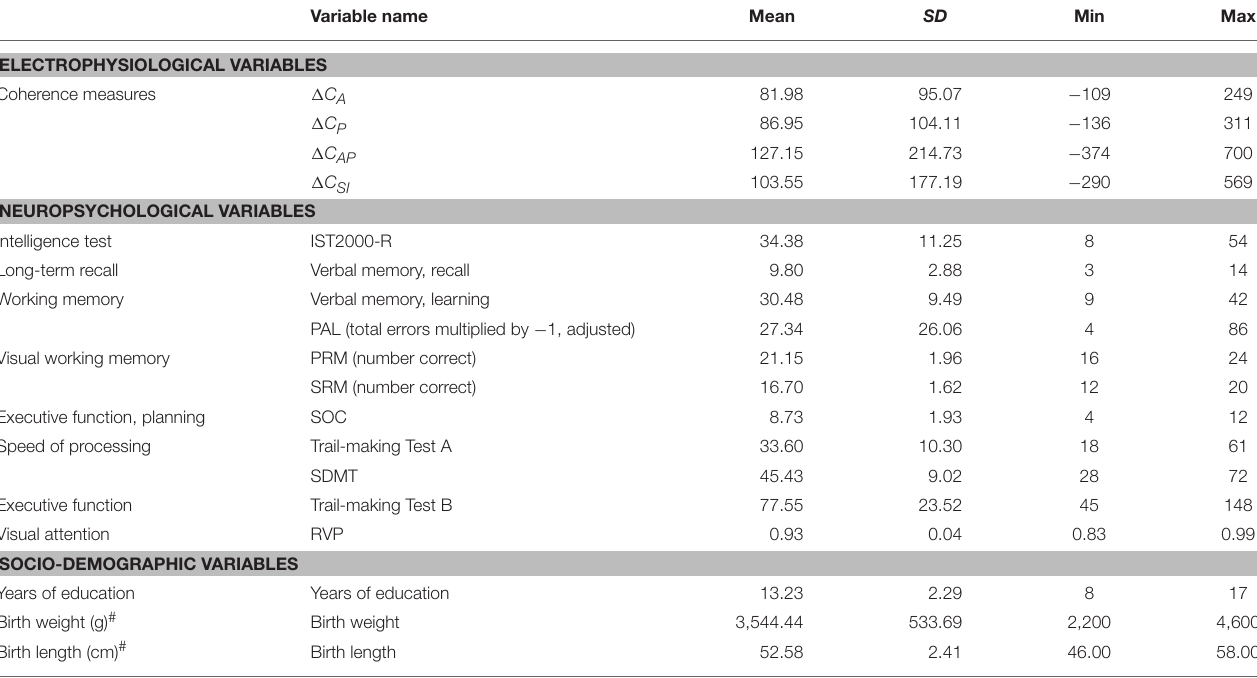
TABLE 1 | Characteristics of the sample and neurocognitive measures ( N =